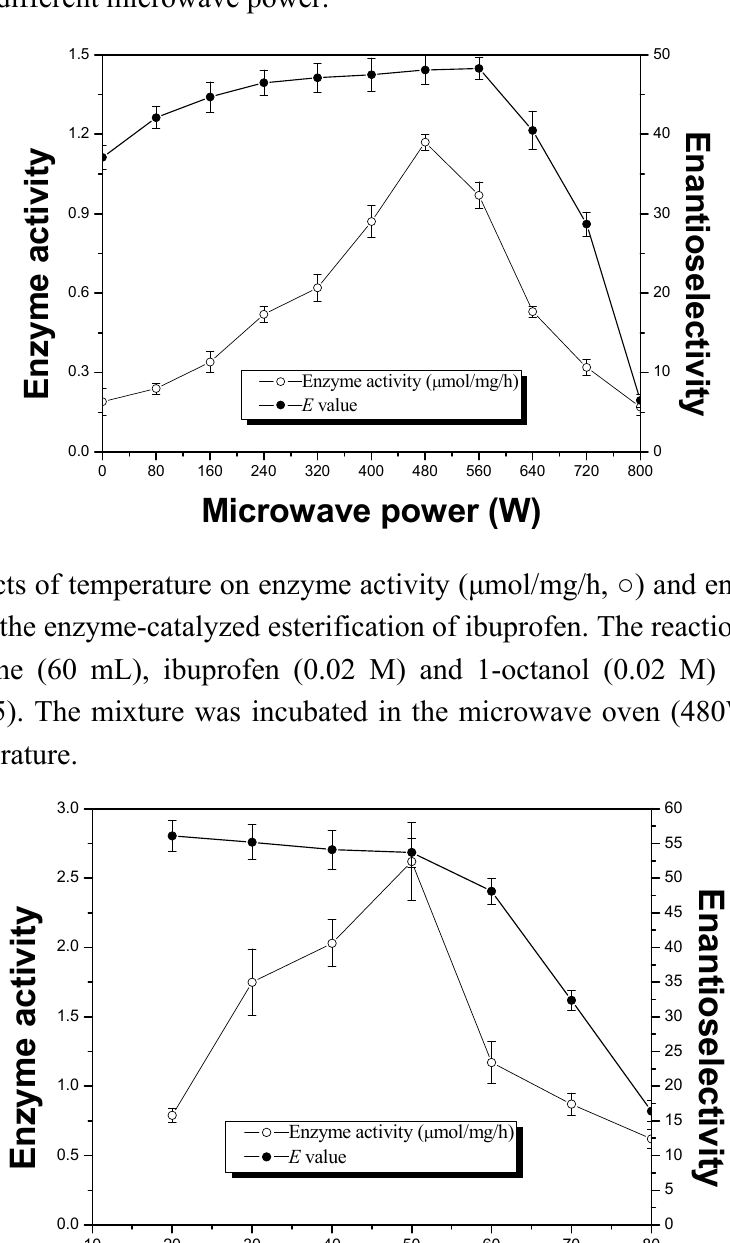
maintaining a higher enantioselectivity, 50 °C was selected as the optimal temperature for this reaction. Figure 1. Effects of microwave power on enzyme activity ( μ mol/mg/h, ○ ) and enantioselectivity ( E value, ● ) in the enzyme-catalyzed esterification of ibuprofen. The reactions were carried out in n -heptane (60 mL), ibuprofen (0.02 M) and 1-octanol (0.02 M) and APE 1547 (60 mg, pH 8.5). The mixture was incubated in the microwave oven (60 °C, 150 rpm) with different microwave power.